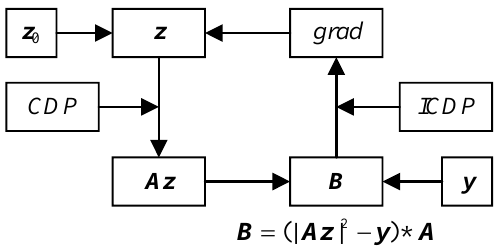
Figure 3. The iterative process of the MRWF algorithm. z 0 value;